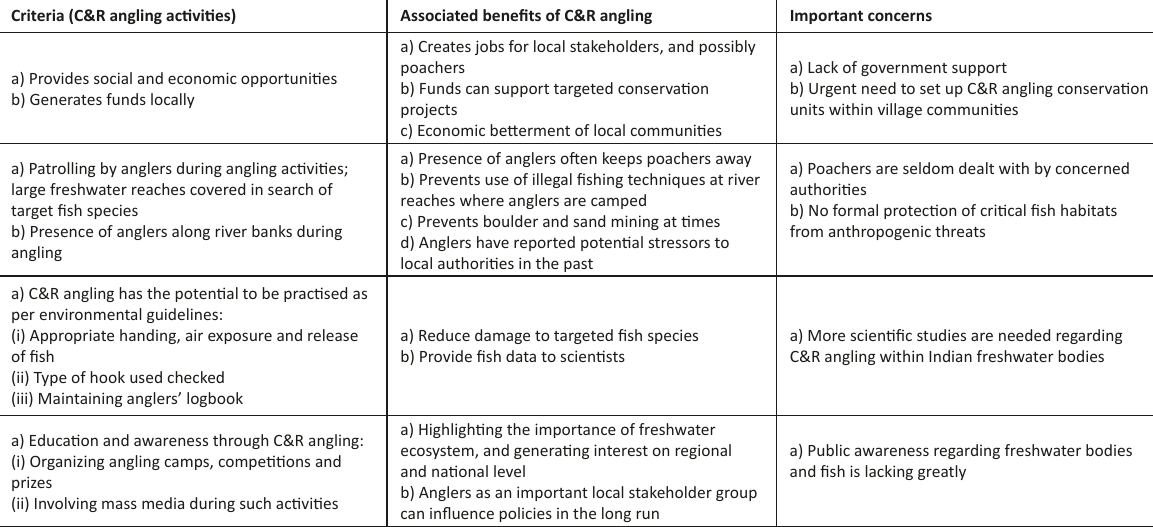
Table 2. Dominant responses from Indian C&R anglers regarding the benefits of angling for freshwater fishes, and their associated Criteria (C&R angling activities)